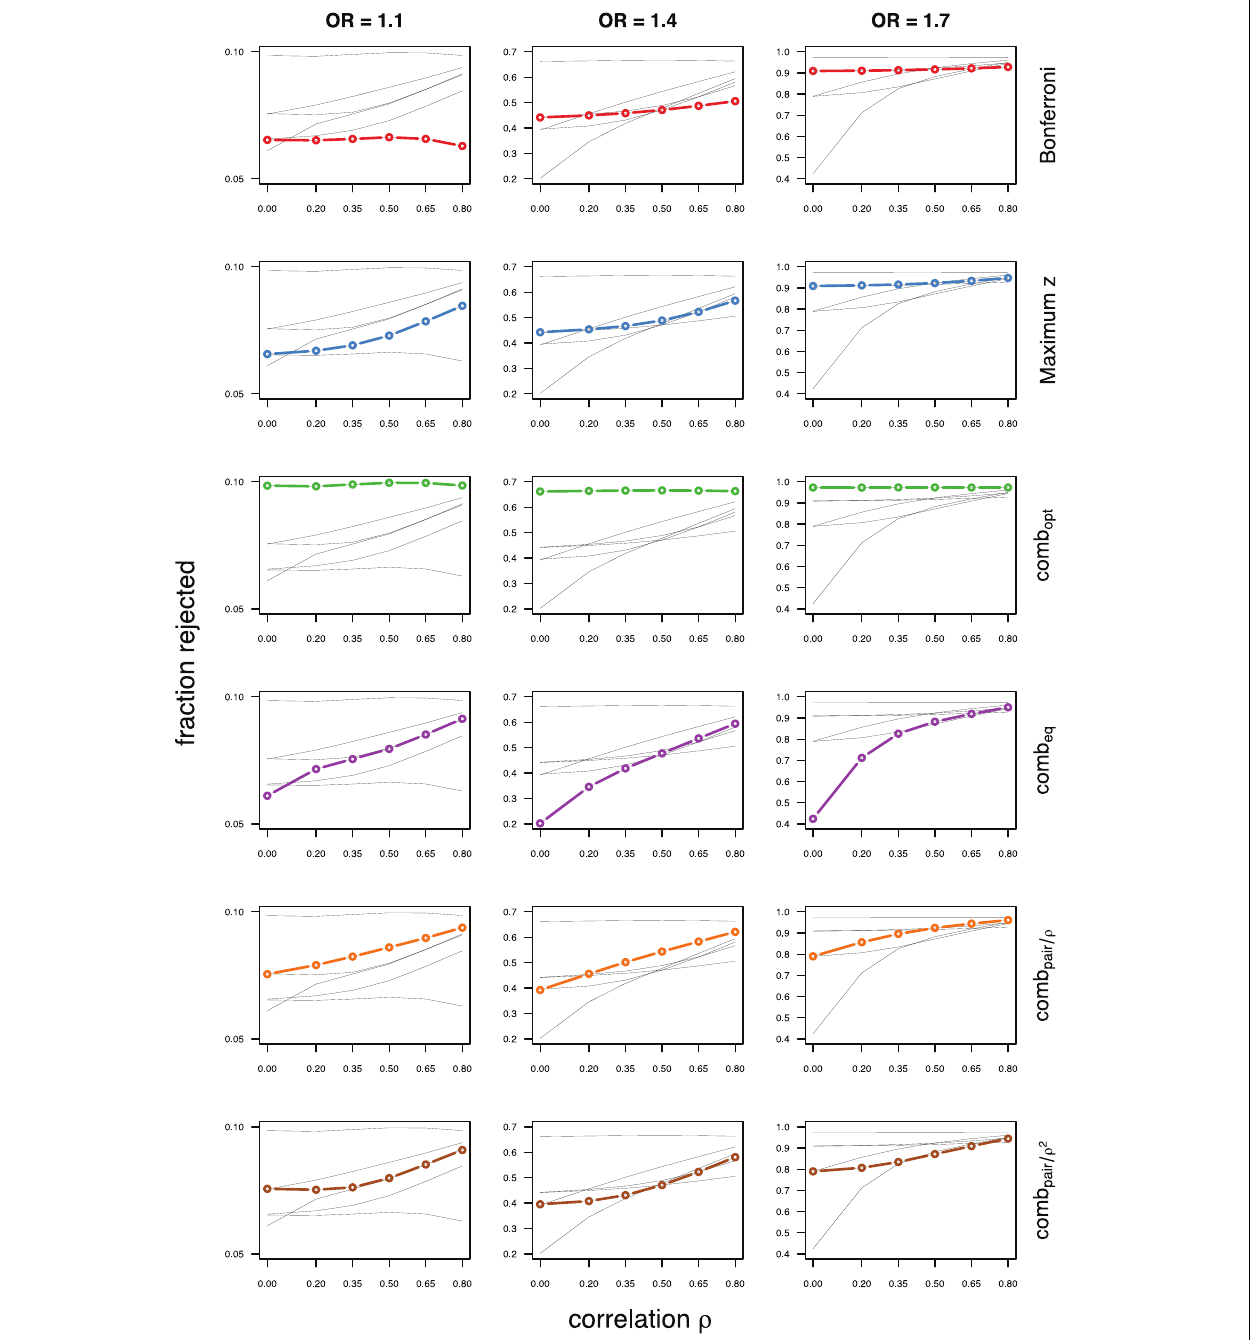
FIGURE 4 | Comparing analytic strategies in the setting with autoregressive correlation structures, assuming equal minor allele frequencies of 5% in a block of 5 markers. The fraction of rejected null hypotheses of no association (power, y-axis) in 50,000